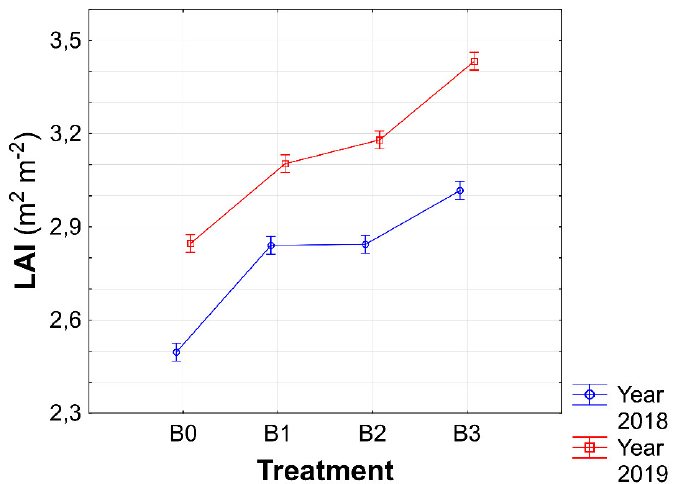
Figure 4. Interactions between biostimulants and experimental years for leaf area index (LAI). B0—